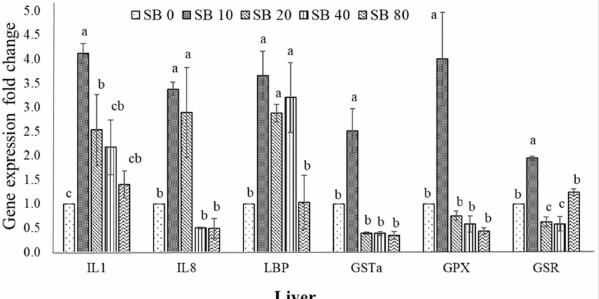
Figure 1. Expressions of immune (interleukin 1, IL1; interleukin 8, IL8; lipopolysaccharide binding protein, LBP) and antioxidant-related genes (glutathione S-transferase, GSTa; glutathione-disulfide reductase, GSR; glutathione peroxidase, GPX) in liver of Nile tilapia after treated with phenol rich. Three replicates. a,b,c Columns without the same superscripts differ ( p < 0.05).